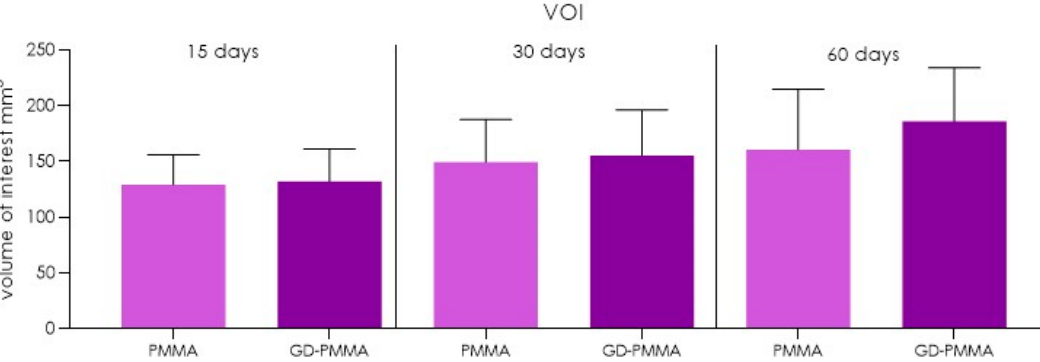
Figure 11. Chart of volume of interest (VOI) between the PMMA implants group and GD-PMMA implants group. A significant difference was detected between PMMA and GD-PMMA groups at 60 days (one-way ANOVA-Tukey’s post hoc test).